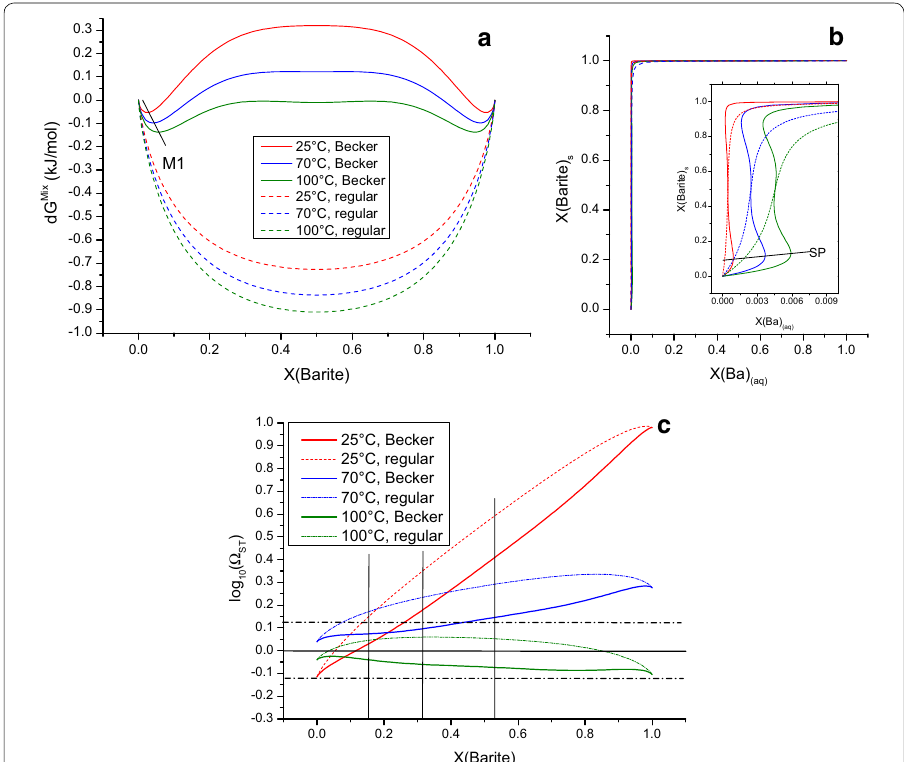
Fig. 5 Thermodynamic characteristics of (Ba,Sr)SO 4 at the conditions considered in this study (cf. Tables 1, 2). a The free energy of mixing is shown according to the two mixing models at various temperatures. M1 indicates the beginning of the miscibility gap predicted by the “Becker” model. b The Rozeboom diagram. It highlights the extreme partitioning of Ba towards the solid. In the insert, the position of the beginning of the spinodal gap according to the “Becker” model is marked by a line labelled SP. b Follows the same legend as the other two. c Displays the stoichiometric saturation state of the aqueous solution with respect to the solid- solution. Vertical lines highlight the approximate solid-solution compositions identified in the scaling sample. Dashed horizontal lines mark the approximate uncertainty range for solubility